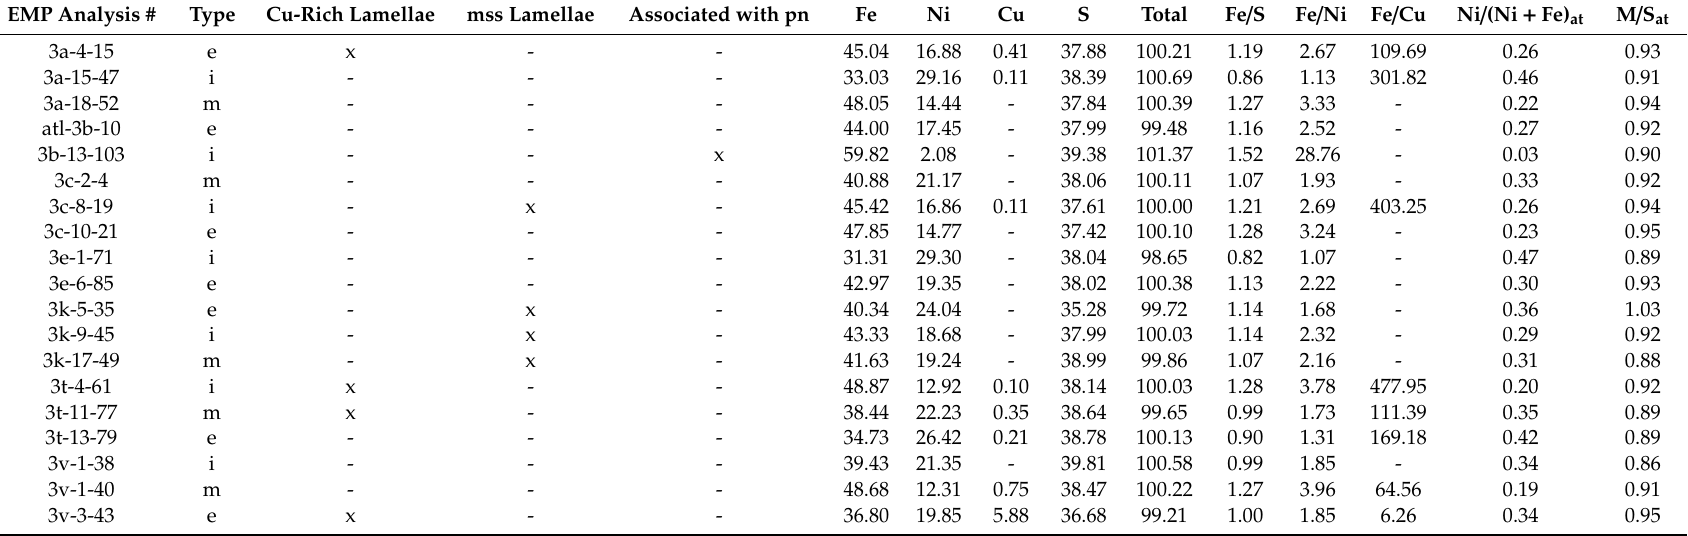
Table 2. Representative electron microprobe (EMP) analyses of mss from Middle Atlas xenoliths. Iron, Ni, Cu, and S contents are given in wt %. Textural occurrence is indicated as e (enclosed), i (interstitial), and m (melt pocket). Exsolution phenomena and associations with pentlandite (pn) are indicated with “x” when abundant. M / S indicates the metal / sulfur ratio. Both M / S and Ni / (Ni + Fe) ratios were calculated for atomic